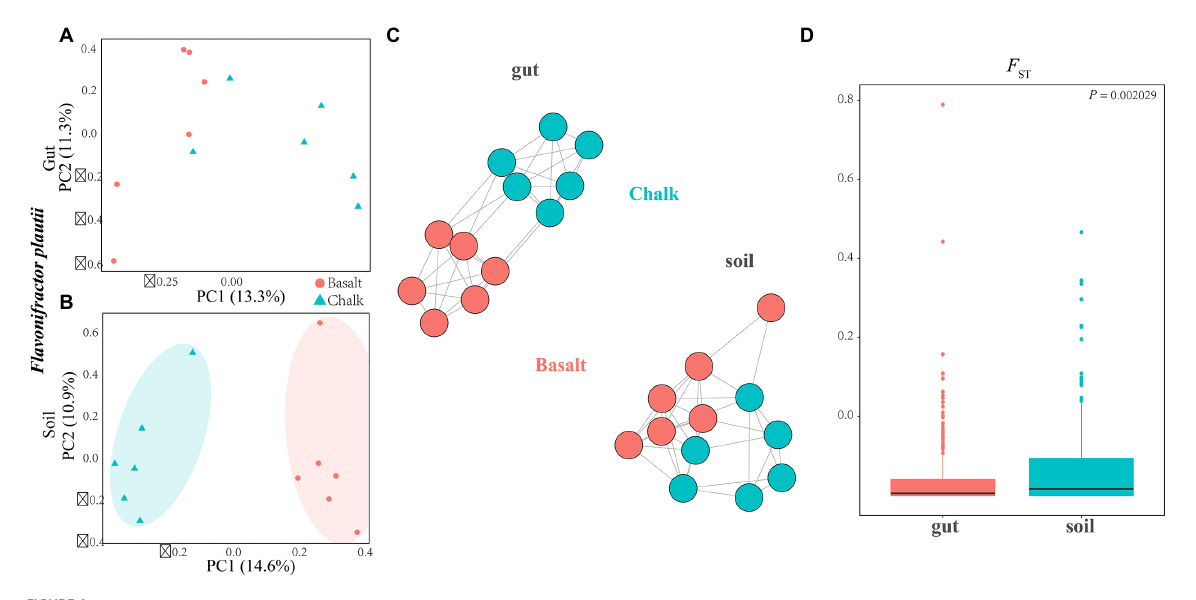
FIGURE 4 Sympatric divergence of the single bacteria of Flavonifractor plautii in gut and soil . (A) Principal component analysis shows the gut microbiome from basalt clustered together and separated with samples from chalk were in one cluster. (B) In soil, principal component analysis shows samples from basalt clustered together and samples from chalk were in one cluster. (C) Genetic network analysis of this species in the environmental soils and gut. (D) F ST for Flavonifractor plautii was significantly higher in soils than that in